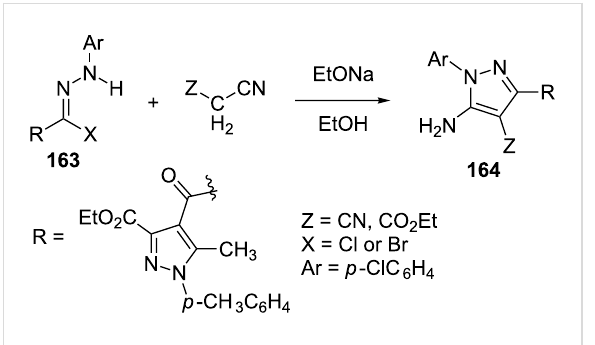
Scheme 47: Synthesis of substituted 5-aminopyrazoles from hydra- zonoyl